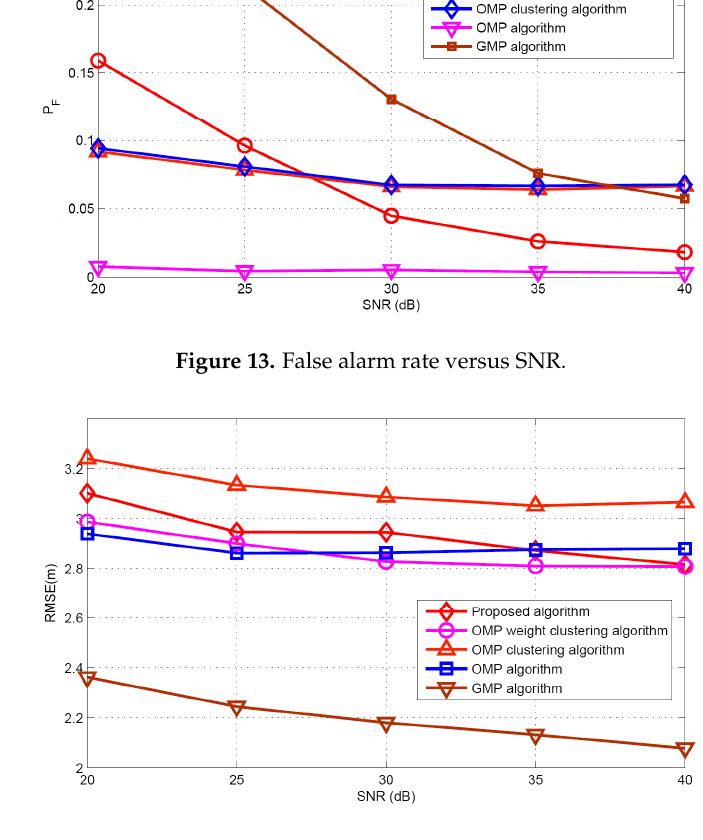
Figure 14. RMSE comparison versus SNR.